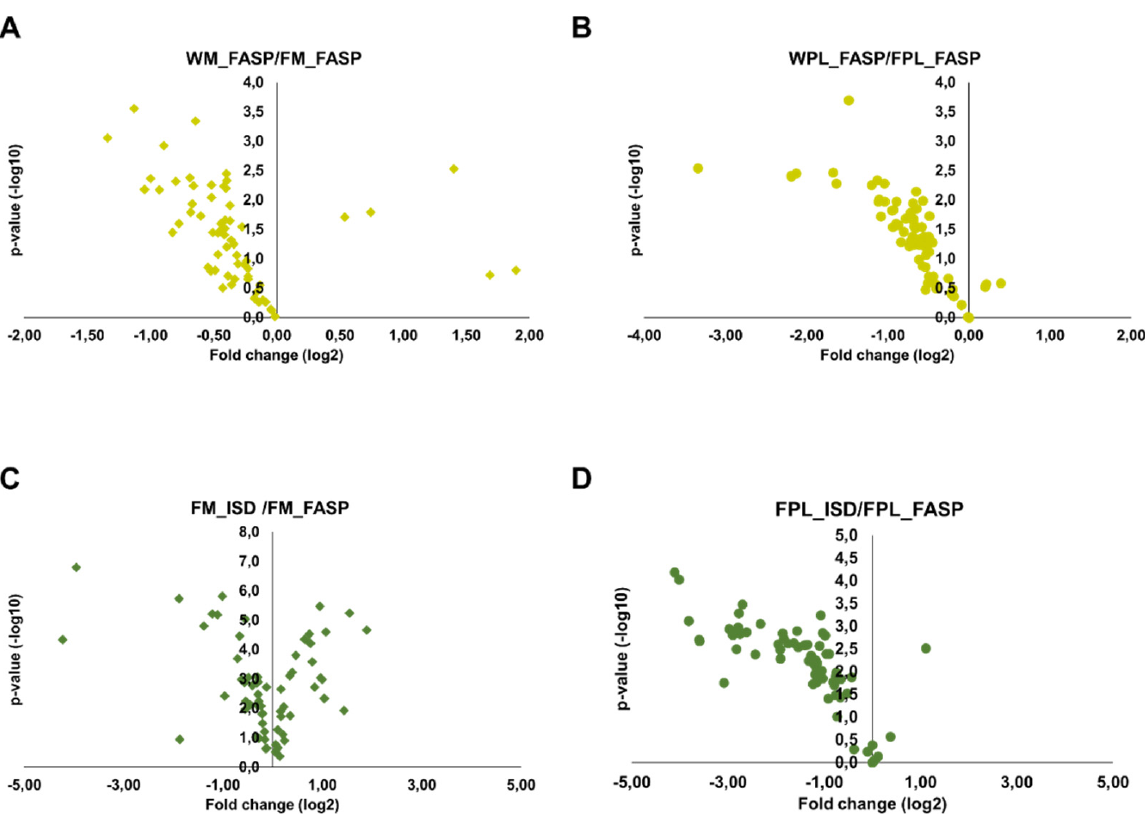
Figure 4. Volcano plots displaying fold changes in protein abundances between the different digestion strategies and the statistical value. The fold change was calculated by dividing the whole sample (FASP digestion) by the Folch precipitated sample (FASP digestion) for ( A ) milk and ( B ) plasma and by dividing the Folch precipitated sample (in-solution digestion) by the Folch precipitated sample (FASP digestion) for ( C ) milk and ( D ) plasma. Experiments were performed in three independent replicates.